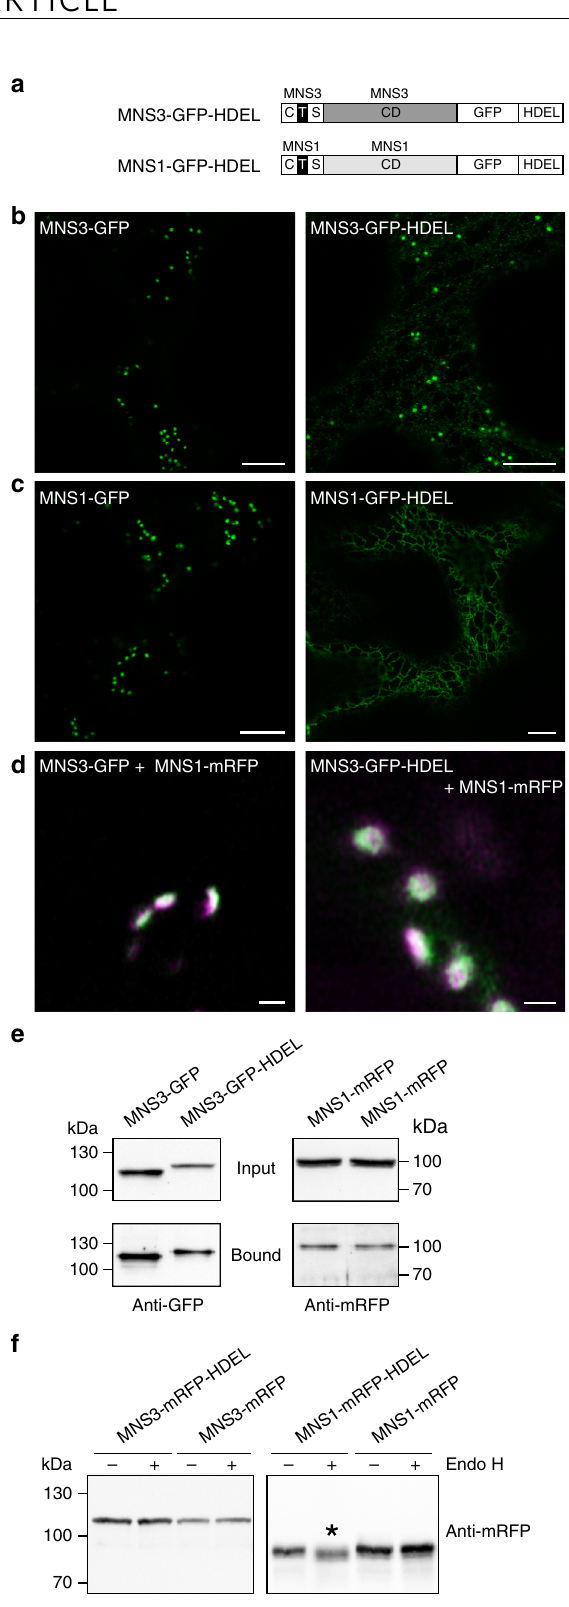
Fig. 5 HDEL-mediated ER retrieval does not induce the redistribution of MNS3 to the ER. a Schematic illustration depicting the domain structure of the protein fusions MNS3-GFP-HDEL (full-length MNS3 C-terminally tagged with GFP and the ER retrieval signal HDEL) and MNS1-GFP-HDEL. b , c Confocal images (2 dpi) showing N . benthamiana leaf epidermal cells transiently expressing ( b ) MNS3-GFP or MNS3-GFP-HDEL, and ( c ) MNS1- GFP or MNS1-GFP-HDEL, respectively. Scale bars = 10 µ m. d High- resolution Airyscan images of Golgi stacks from N . tabacum leaves labelled with MNS3-GFP (green) and MNS1-mRFP (magenta) or MNS3-GFP-HDEL (green) and MNS1-mRFP (magenta). Scale bar = 1 µ m. e MNS3-GFP